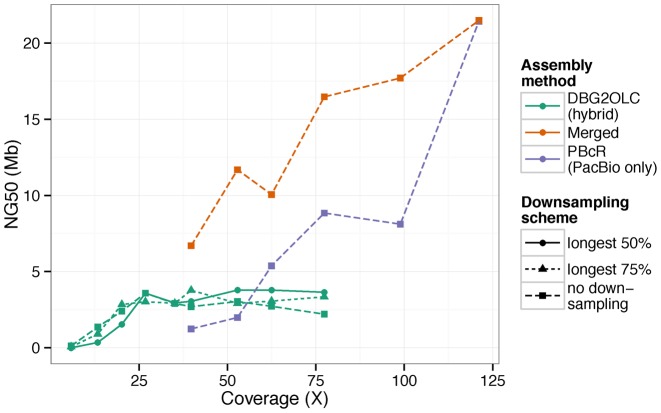
The NG50 of D. melanogaster assemblies produced using a variety of data sets. NG50 here is the contig size such that at least half of the 130Mb D. melanogaster genome (65 Mb) is contained in contigs of that size or larger. ‘longest 50%’ and ‘longest 75%’, respectively, refer to datasets in which only the longest 50 or 75% of the available reads have been used. The coverage listed on the x-axis in this case refers to the total amount of available data (before downsampling by length).